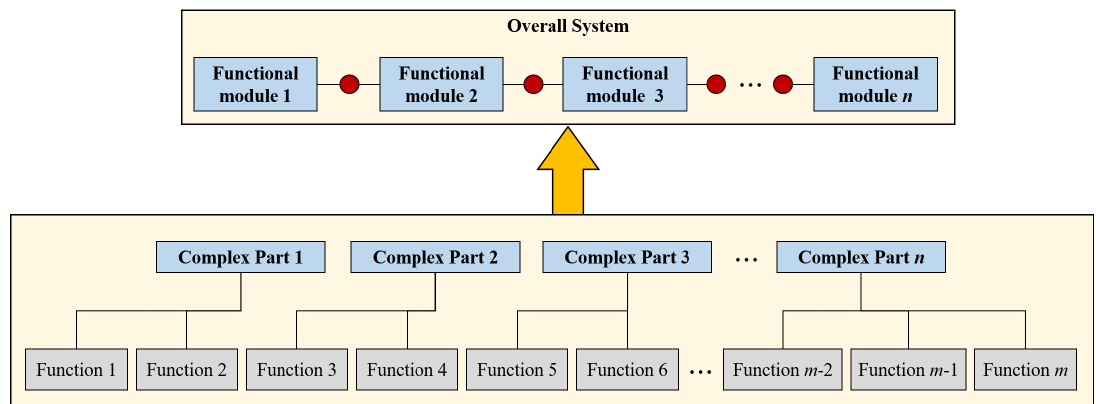
Figure 5. Combination-of-Features concept (adapted from